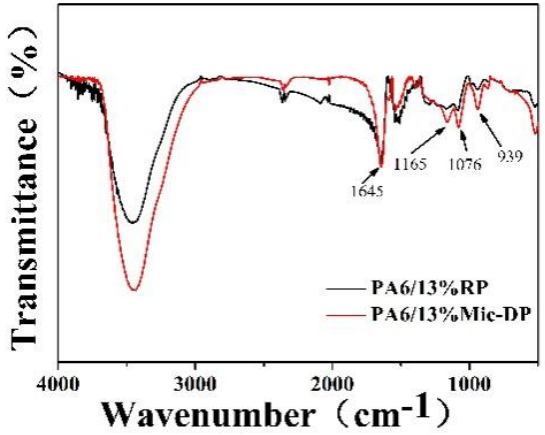
Figure 10. FTIR spectra of residual char from PA6 samples.